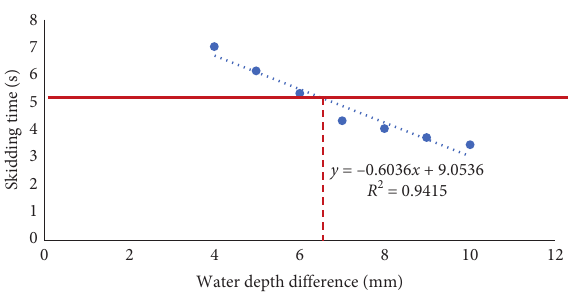
Figure 11: Correlation between vehicle slip time and water depth difference. Table 2: Comparison of lengths of dangerous road sections obtained by complete hydroplaning- and sliding-based methods.